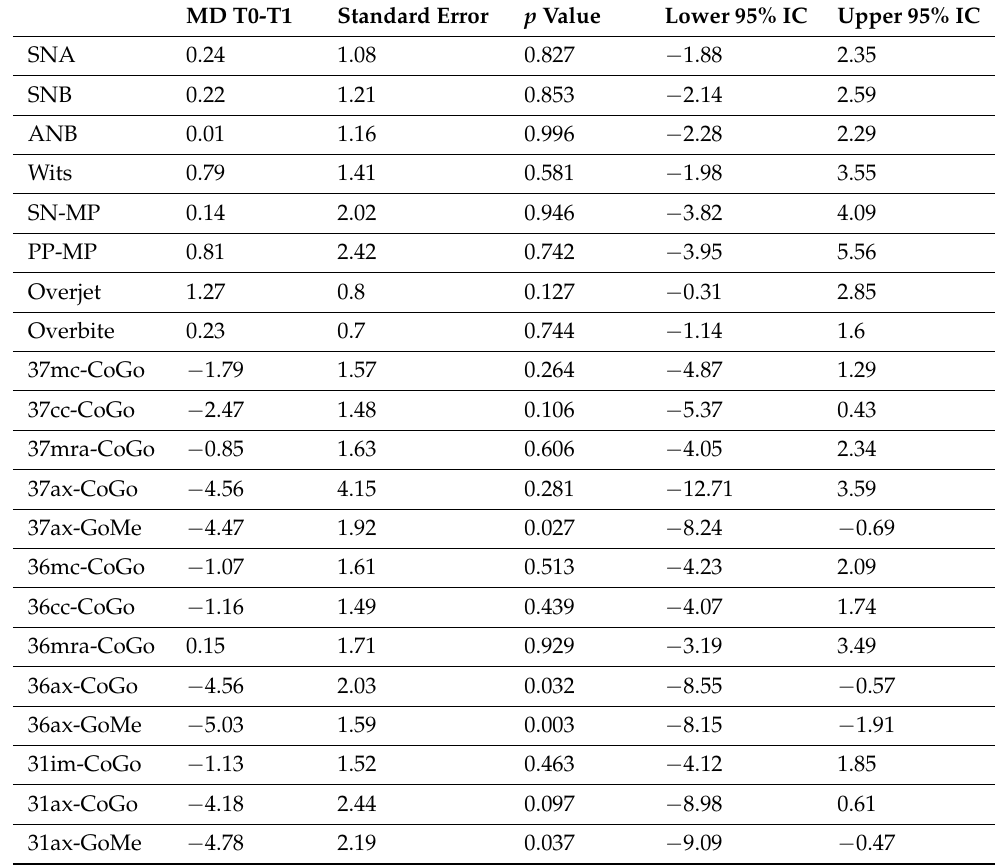
Table 1. Cephalometric values